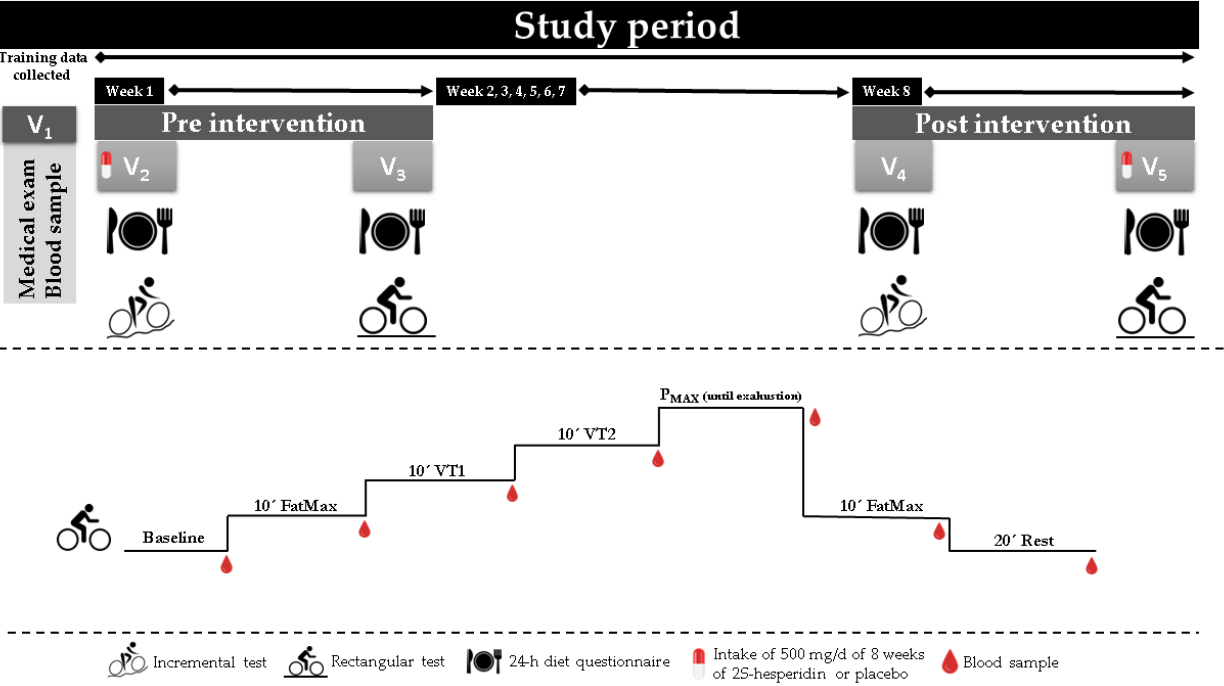
Figure 1. ( A )-Study plan, 2S-Hesperidin intake was consume for eight weeks (visit two to visit five). ( B )–Rectangular test, seven finger capillary blood samples were taken and analyzed on the ABL-90 FLEX blood gas meter. Table 3. Between-group comparisons in dietary intake of cyclists.